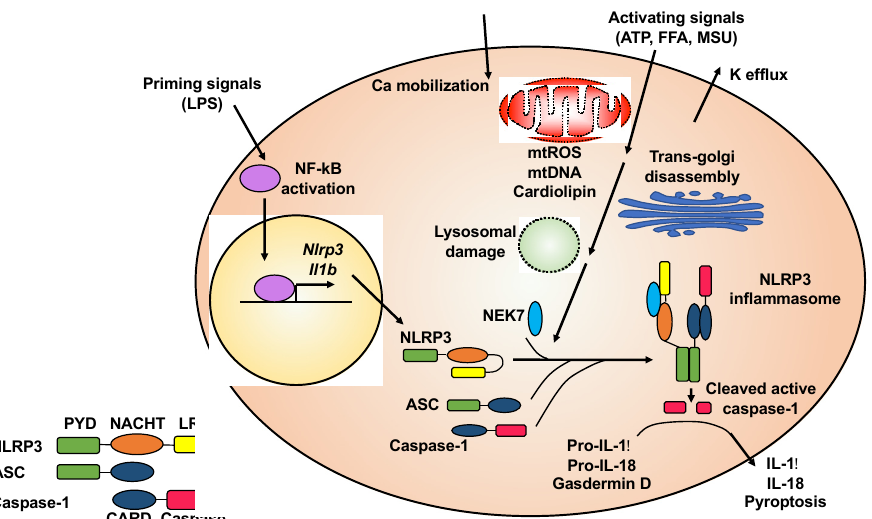
Figure 1. Molecular mechanisms of NLRP3 inflammasome activation. The NLRP3 inflammasome is activated through an initial priming step followed by an activating step. The priming signals, such as lipopolysaccharide (LPS), activate NF- κ B signaling, which induces transcription of the Nlrp3 and Il1b genes. The activating signals, such as ATP, nigericin, free fatty acids (FFAs), monosodium urate (MSU) or cholesterol crystals, can trigger a series of cellular events, which typically include potassium efflux, calcium mobilization, mitochondrial (mt) damage (leading to release of reactive oxygen species (ROS), DNA, and cardiolipin), trans-Golgi disassembly, and lysosomal rupture. These upstream cellular events converge on the NLRP3 protein, causing its conformational change and leading to oligomerization of NLRP3 with the assistance of NEK7 protein. Oligomerized NLRP3 recruits ASC, which further recruits caspase-1, to form the NLRP3 inflammasome complex. Caspase-1 autocleaves itself to generate the active enzyme, which cleaves pro-IL-1 β and pro-IL-18 to release mature cytokines. Active caspase-1 also cleaves gasdermin D to induce pyroptosis. Both cytokine release and pyropototic cell death trigger inflammation.